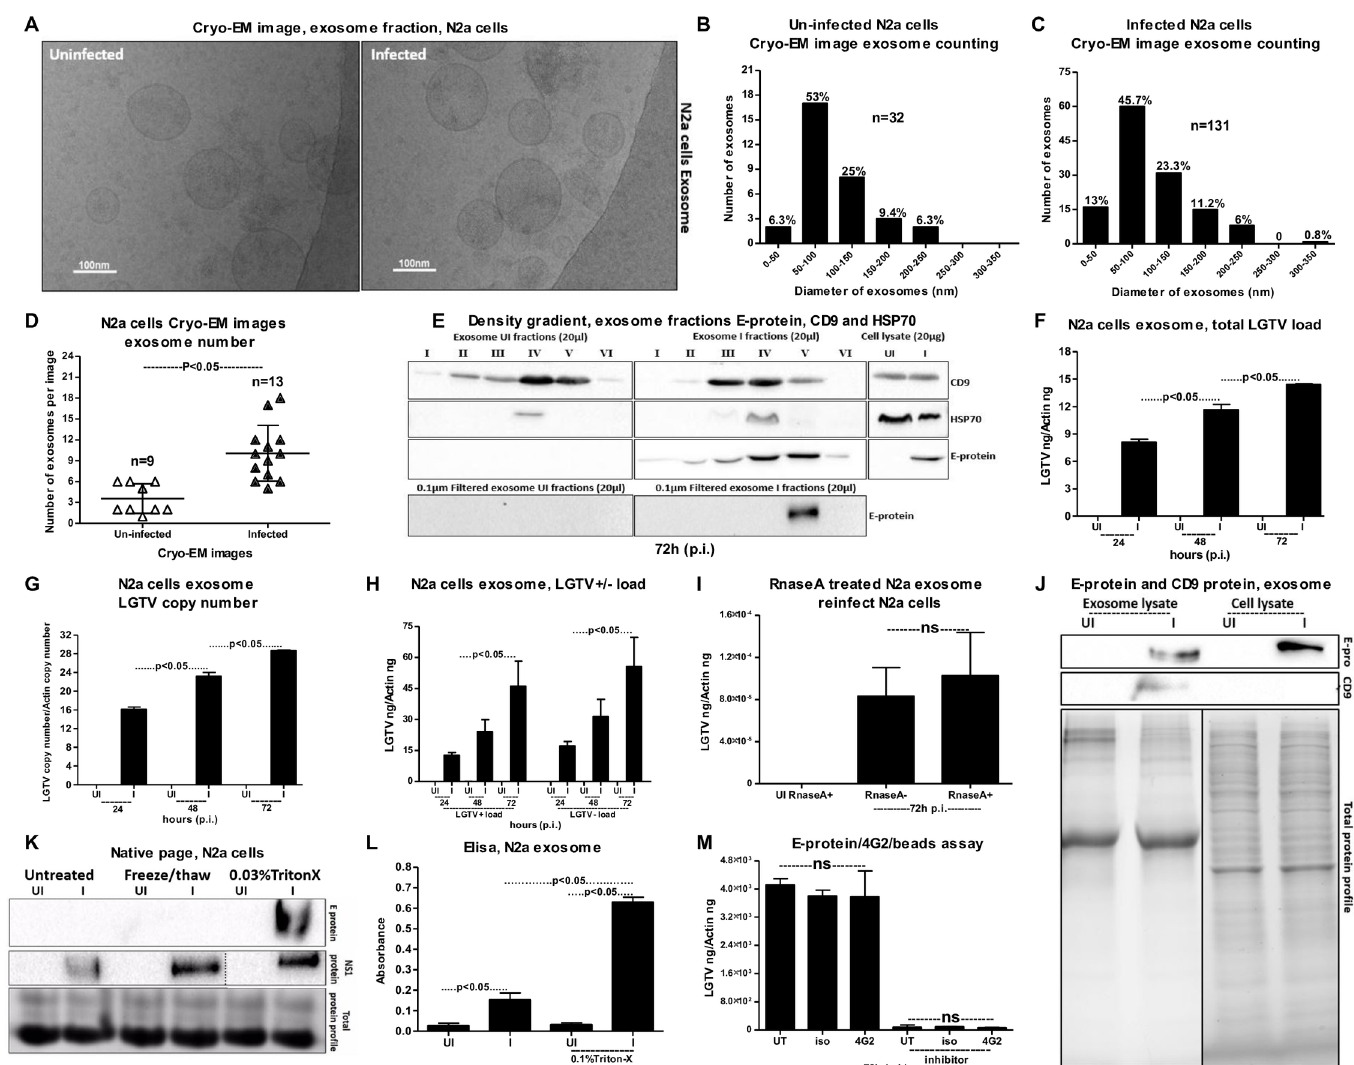
Fig 3. Detection of LGTV RNA and proteins in exosomes isolated from N2a neuronal cell line. (A) Cryo-EM images showingexosomes isolated from uninfectedand LGTV-infected (MOI 6; 72 h p.i.), N2a cells (1 x 10 7 ). Scale indicates100nm. Quantificationof diameter or sizes for heterogenous populationof exosomesfrom uninfected(B) or LGTV- infected (C) N2a cell-derivedexosomes. Number of exosomes analyzedwere n = 32 (uninfected) and n = 131 (infected) groups. (D) Comparisonof exosome numbersper image from uninfected(n = 9) and infected (n = 13) groups is shown. (E) DG-Exos showing presenceof enhanced LGTV envelope[E]-protein loads in fractions 1–6. Fractions 3–5 showedenrichedamounts of exosomal markers CD9 and HSP70. E- protein detectionin fraction 5 in 0.1 μ m filtered samples processedfor OptiPrep DG-isolation is shown. QRT-PCR analysisshowinglevels of total LGTV loads (F), copy numbers(G) and LGTV positive-sense strand or negative-sense strand (H) in exosomes isolatedfrom N2a cells at different time points. N2a (1 x 10 5 ) cells were infected with 6 MOI of LGTV, and LGTV loads were analyzedat 72 h p.i. (I) Treatment of LGTV-infected (72 h p.i.) N2a cell-derivedexosomes with RNase A is shown. The uninfectedsamples treated with RNase serve as control. LGTV transcript levels were normalized to mouse beta-actin. (J) Immunoblotting analysisshowingdetection of LGTV E glycoprotein and mammalian exosomalmarker CD9 in exosome fractions and total lysates from whole cells preparedat 48 h p.i. from 2 x 10 6 uninfected(UI) or infected (I) N2a cells. Stain-free gels showingtotal protein profiles serve as the loadingcontrol. (K) Native-PAGE followedby immunoblotting analysisshowingpresenceof LGTV E- and NS1 proteinsfrom LGTV-infected (MOI 1; 72 h p.i.) or uninfectedN2a cell-derivedexosomes treated with Triton-X-100 (0.03%), or freeze-thawcycles (3 times freezingat -80˚C for 1 h each cycle) or untreated, held on ice. Coomassie stained gel image showingtotal protein profilesserve as a loadingcontrol. (L) ELISA performed on uninfectedor LGTV-infected (MOI 6; 72 h p.i.) N2a cell-derivedexosomeseither untreatedor treated with Triton-X-100 (0.1%). (M) Antibody-beads bindingassay performed on LGTV infected (MOI 1, 72 h p.i.) N2a cell-derivedexosomes(collected from N2a cells either untreated or treated with GW4869; 5 μ M, exosome inhibitor)showingno differencesin LGTV-E protein loads between4G2 or isotype and